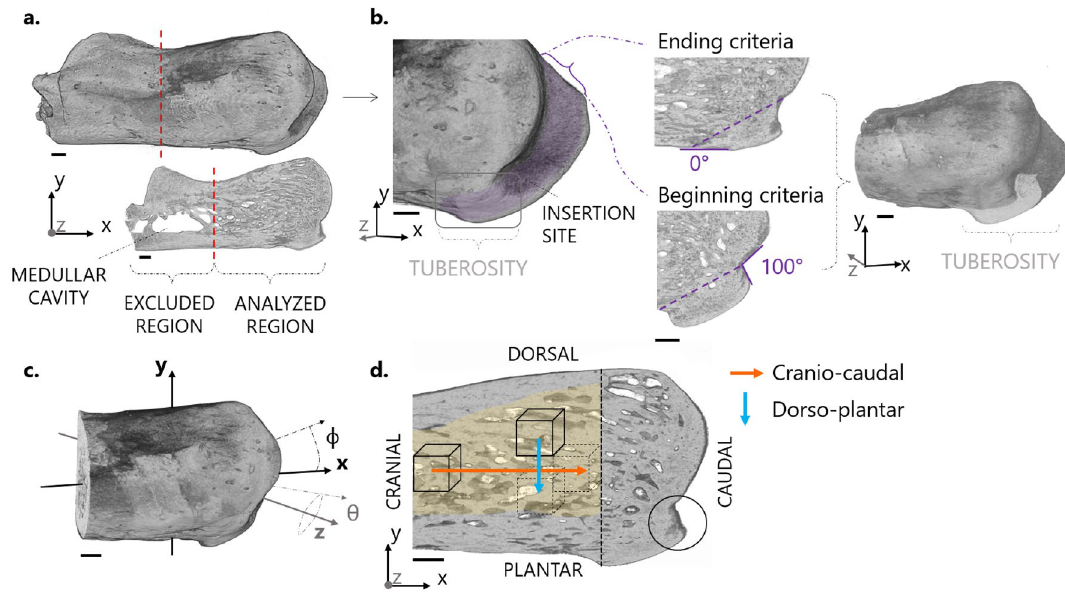
Figure 2. Image segmentation and reference coordinate system. ( a ) Three-dimensional rendering and typical sagittal section of a reconstructed and realigned calcaneus bone at 5 μm resolution. The cutting plane (red dashed lines) demarcates the analyzed region. ( b ) Cropped bone with a close up on the insertion site. The cross- sections considered for the tuberosity analysis are highlighted in purple. The anatomical landmarks to identify the tuberosity in the sagittal plane are also illustrated, together with the cutting orientation (dashed lines) used for the segmentation of the tuberosity. ( c ) Representation of the spherical coordinate system with the azimuthal ( ) and polar (θ) angles used to define the orientation of microstructural features. ( d ) Illustration of the cubic volumes of interest defined for the spatially resolved analysis of the trabecular network (the analyzed trabecular ϕ compartment is highlighted in yellow). Cubes were displaced along two directions: cranio-caudal (orange arrow) and dorso-plantar (blue arrow). Scale bars: 500